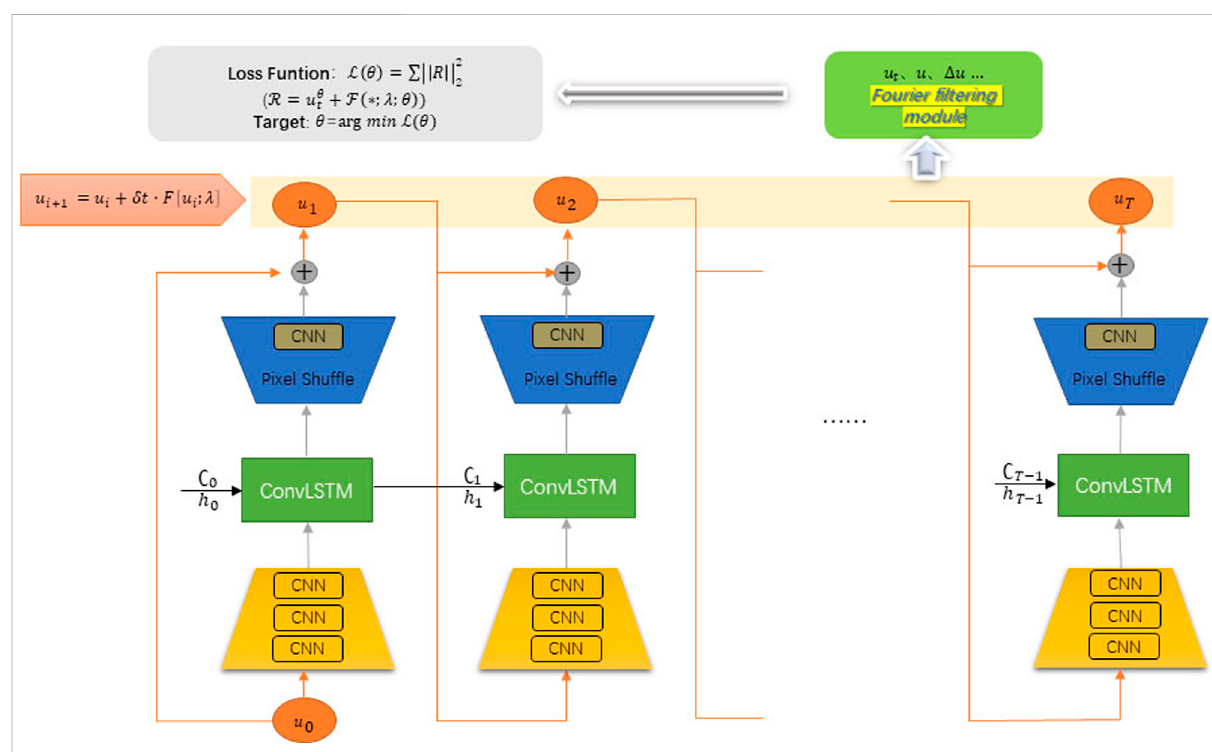
The architecture of Fourier fi lter-based PhyCRNet. It comprises CNN layers with activation functions in the encoder. In the decoder, Pixel Shuf fl e conducts super-resolution reconstruction to obtain the resolution of the input value, and considers a CNN layer without an activation functionfor convolutionprocessing.HandC arethehiddenstate andcell state ofConvLSTM, respectively. Alloutputsare incorporated intotheloss function using DFT and IDFT. Fourier transform loss function with